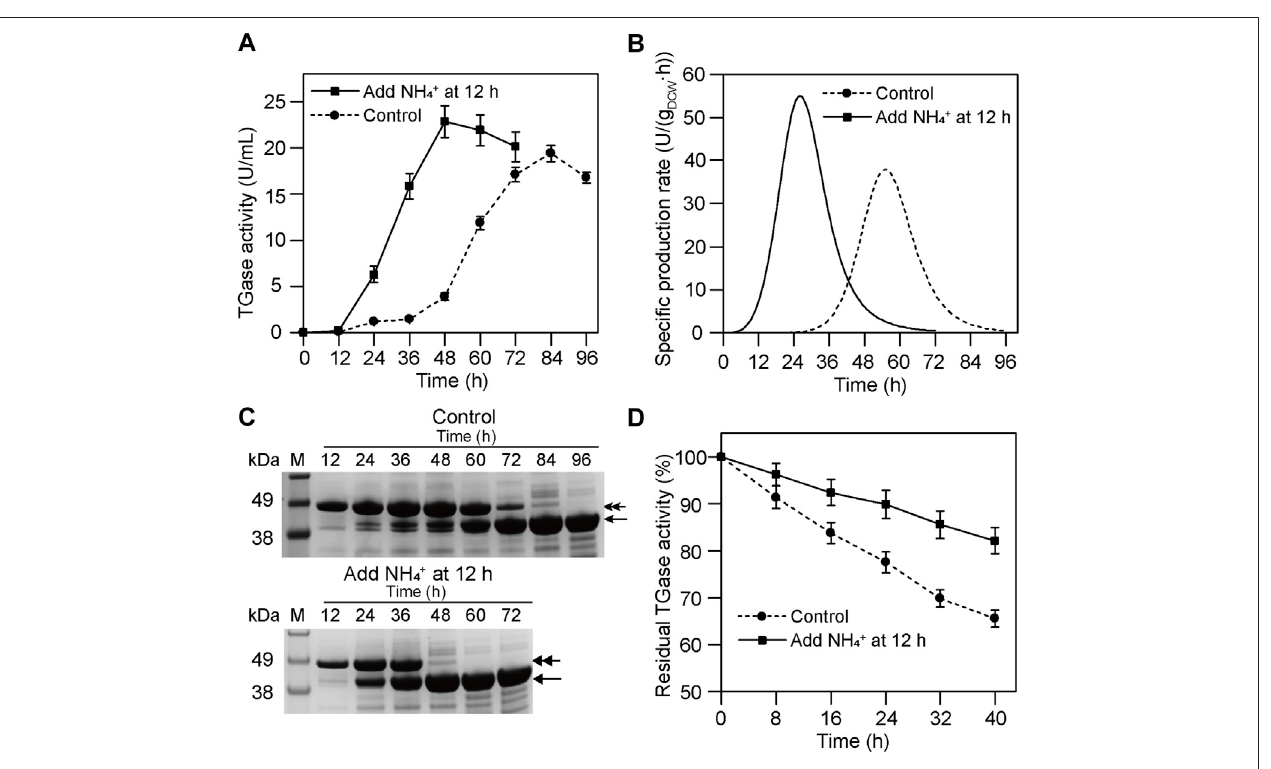
FIGURE3| EffectsofNH 4+ onTGaseproductionbysmY2019. (A) TimecourseofTGaseproduction. (B) Speci fi cproductionratecurveofTGase. (C) SDS-PAGE analysis of the culture supernatant. The pro-TGase and TGase bands are indicated with double and single arrows, respectively. (D) Storagestability of the crude TGase solution at room temperature. The crude TGase solution referred to 48-h culture supernatant with 60 mM NH 4+ addition. The 84-h culture supernatant without addition of NH 4+ was used as a control. NH 4+ was added in the form of (NH 4 ) 2 SO 4 .